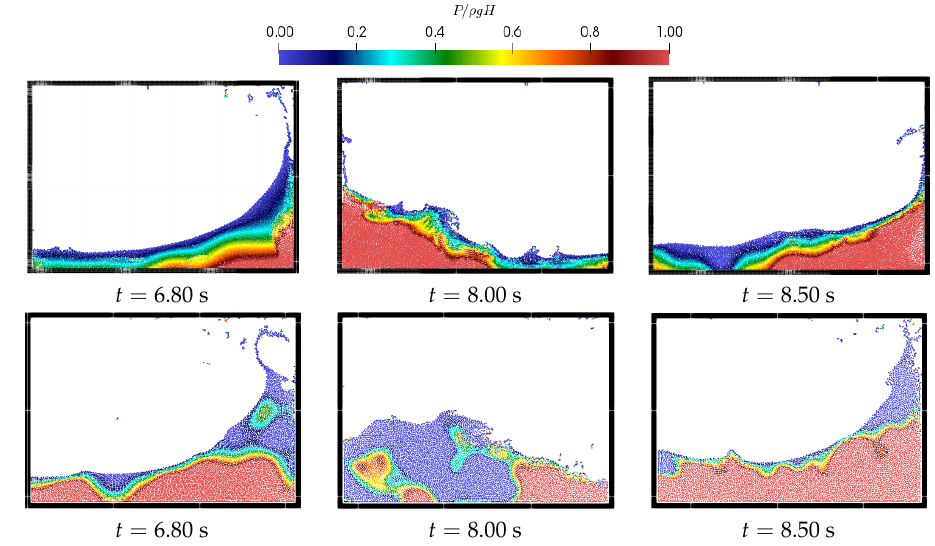
Figure 29. Sloshing in a rectangular tank: Snapshots of pressure field at times t = { 6.80,8.00,8.50 } s, The first row depicts the results obtained by the present method. The second row presents the results obtained with IPST